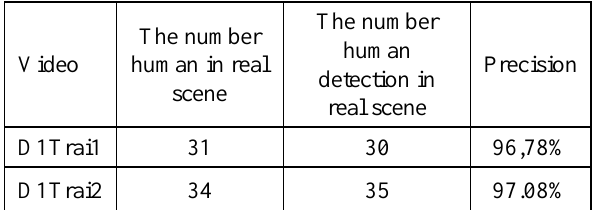
Table 1. The result of human detection in real scene